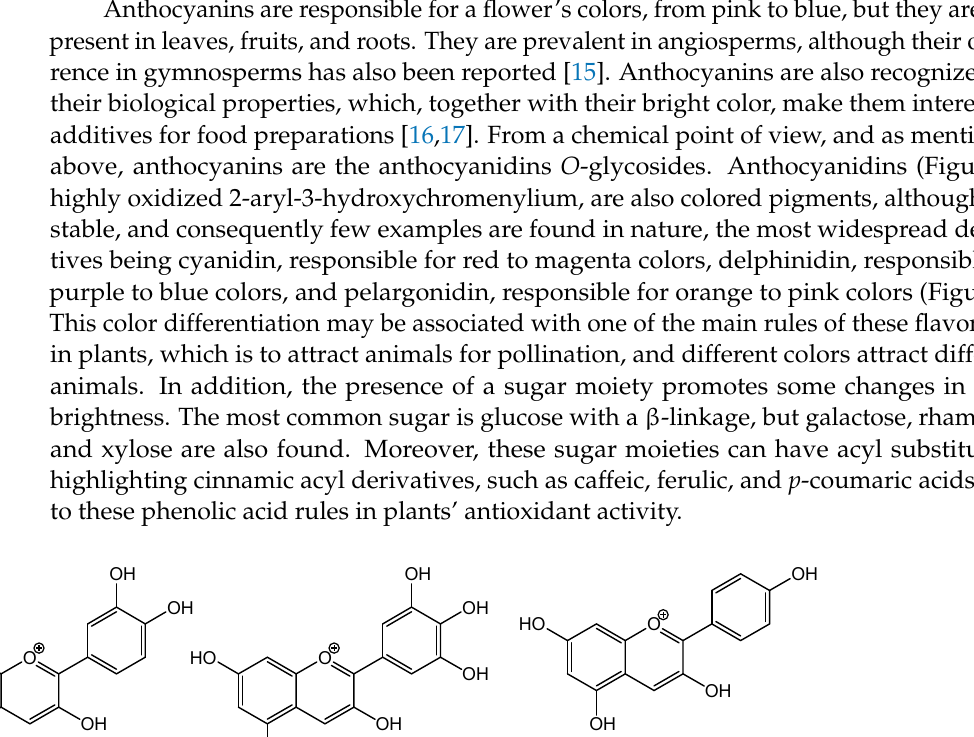
[18]. Figure 3. Examples of representative flavanones and dihydroflavonols. Dihydroflavonol, 2-aryl-3-hydroxychroman-4-one (Figure 1), biosynthesis involves an oxidative hydroxy group addition at flavanones’ C-3 position, which is the reason why they are often designated as 3-hydroxyflavanones. One of the most common derivatives that is also the primary scaffold for several other naturally occurring dihydroflavonols is taxifolin (Figure 3). These flavonoids are also found linked to sugars, an important exam- ple being astilbin, which shows remarkable anti-inflammatory activity [19] and is linked to other groups, such as prenyl and methoxy groups.